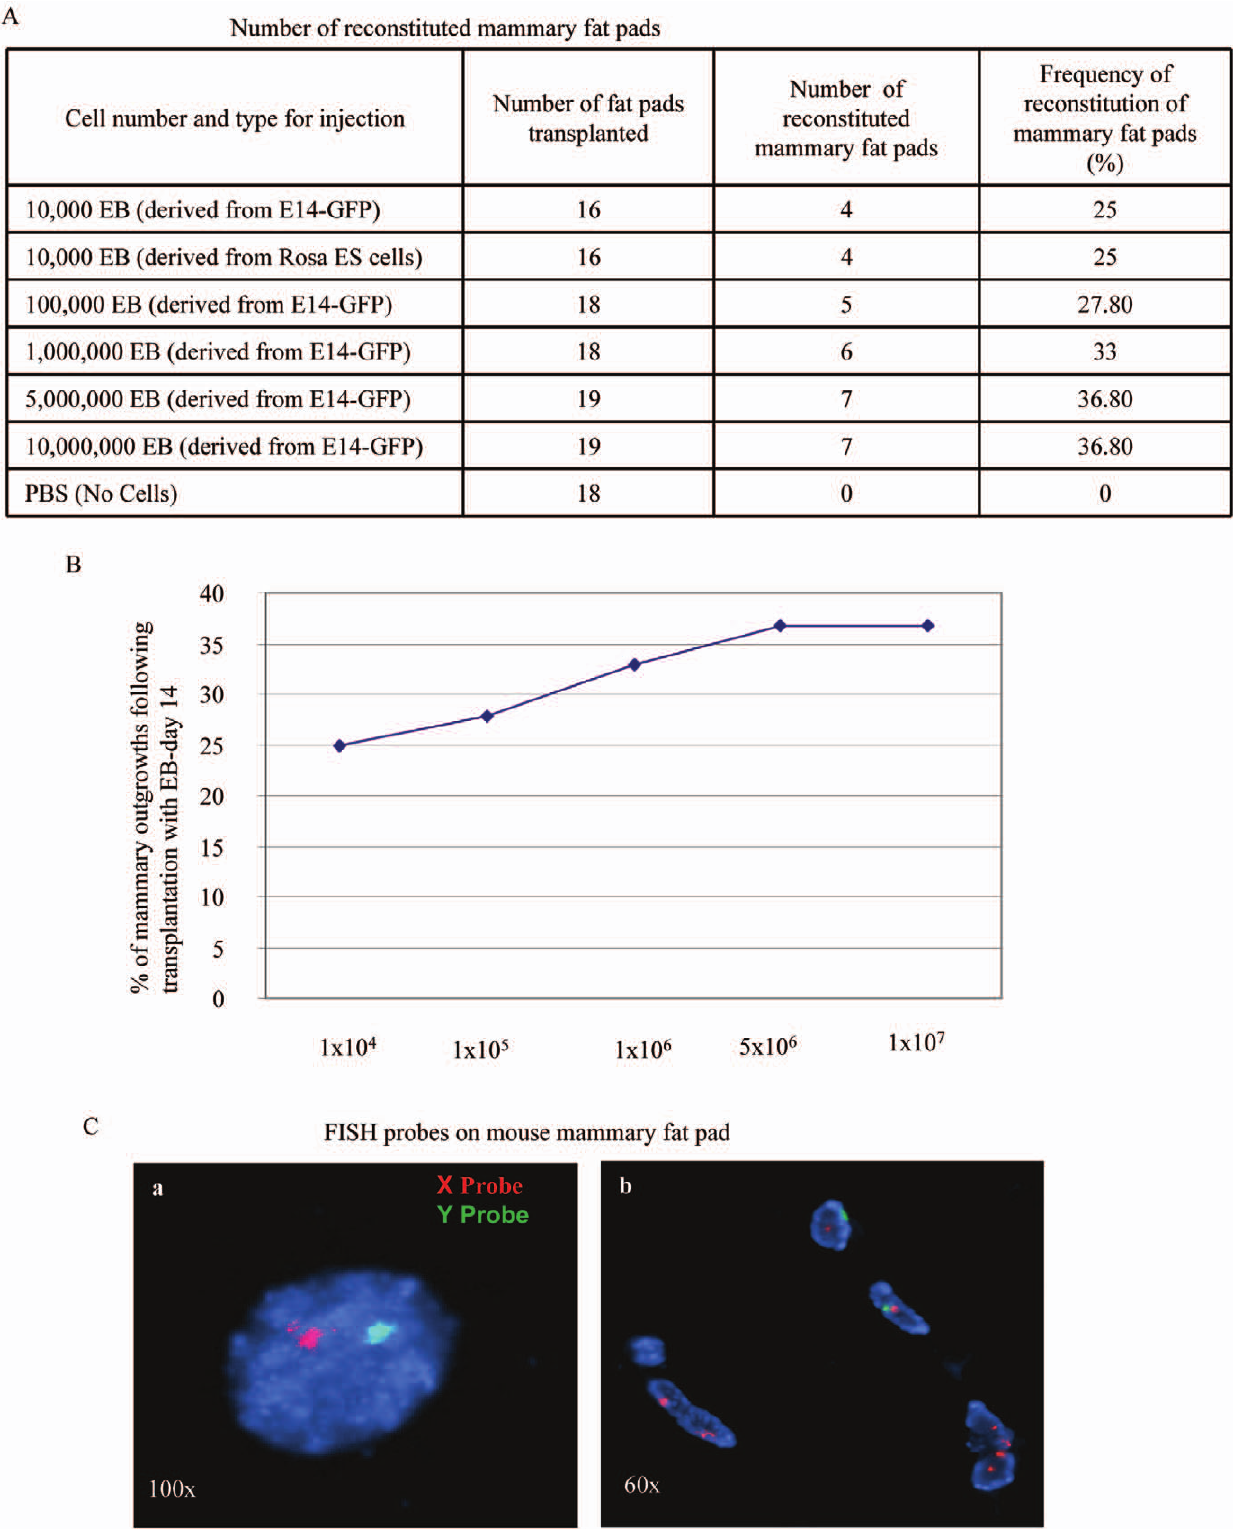
Figure 5. Effects of increasing numbers of hematopoietic EB-derived mES cells on mammary epithelial morphogenesis. (A) Immunostaining and whole-mount analysis of epithelial outgrowths induced bytransplantation of day14 EBs. (B) The mammary fat pads were analyzed with carmine staining, GFP staining, CK 14, CK 18 and by whole mount analysis of epithelial outgrowths arising from transplantation. (C) FISH with mouse X and Y chromosome probes on reconstituted mammary gland. Mouse X and Y chromosome FISH analysis were used on paraffin- embedded sections of reconstituted mammary glands with mEBs derived from E14-GFP mES cells at day 14. The X chromosome was labeled in red